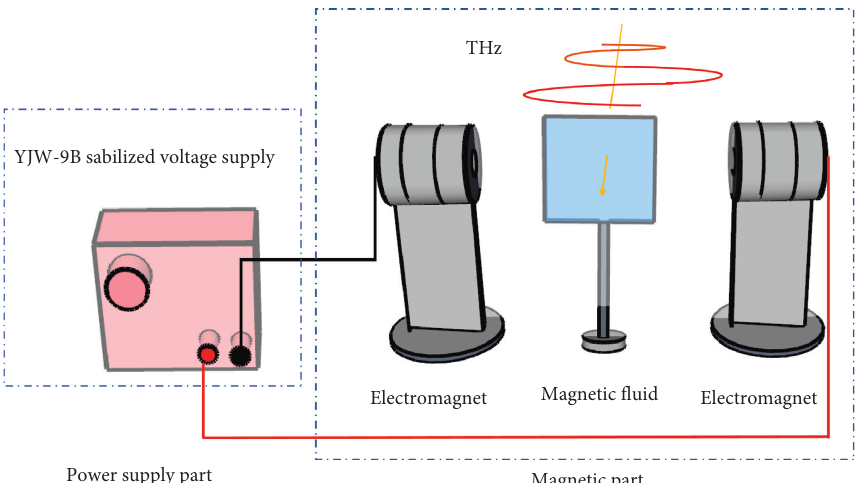
Figure 4: Diagram of a vertical magnetic field system.